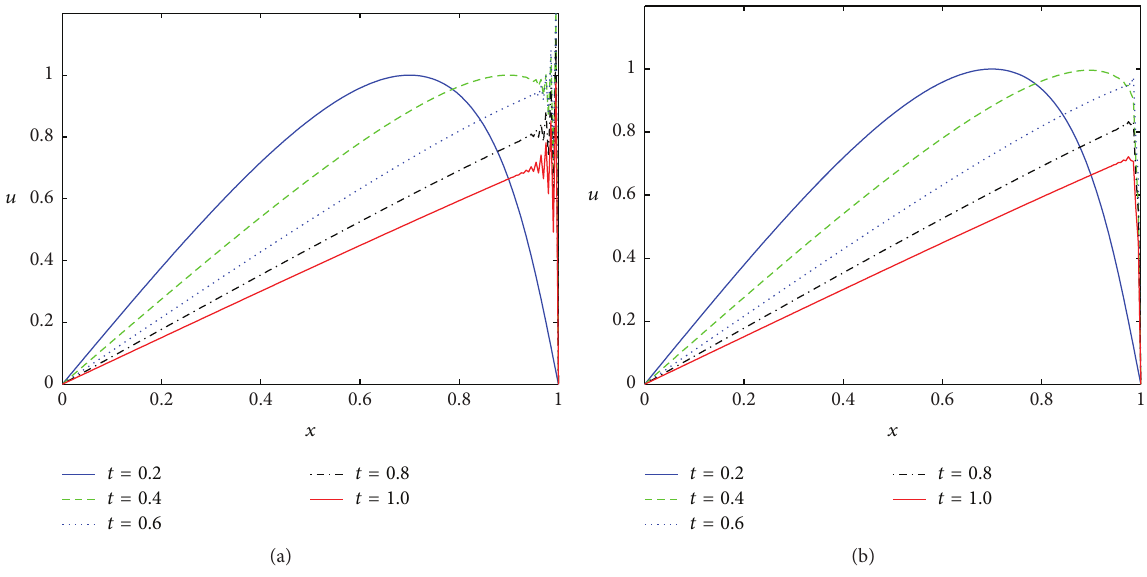
Figure 7: Effects of filtering for solving one-dimensional Burgers’ equation for Re = 10 5 by the VMEFG method. (a) is obtained without filter and (b) is with low-pass filter.